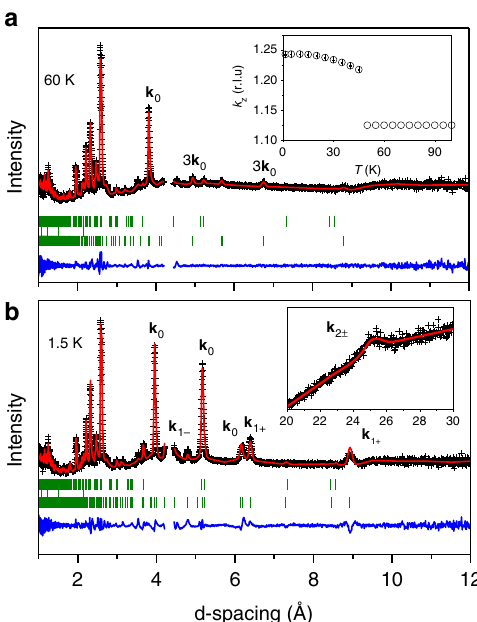
Fig. 3 Neutron diffraction data of the perovskite-type Mn 2 O 3 . a , b Rietveld re fi nement of the WISH neutron diffraction patterns collected at 60 K and 1.5 K, respectively. The black cross symbols and red solid lines represent the experimental and calculated intensities, respectively. The blue lines at the bottom of both plots are the difference between the experimental and calculated intensities. There are three sets of tick marks: the upper one indicates the positions of Bragg peaks for the nuclear, the middle one shows a few re fl ections of the vanadium can for the sample, and the lower one indicates the positions of Bragg peaks for magnetic scattering. The inset in a shows temperature dependence of the k z -component of the magnetic propagation vector k 0 . The inset in b shows magni fi ed portion of the diffraction pattern where a satellite of the k 2± propagation vector is observed ground state (Fig. 4b). Apart from k 0 , a set of additional magnetic